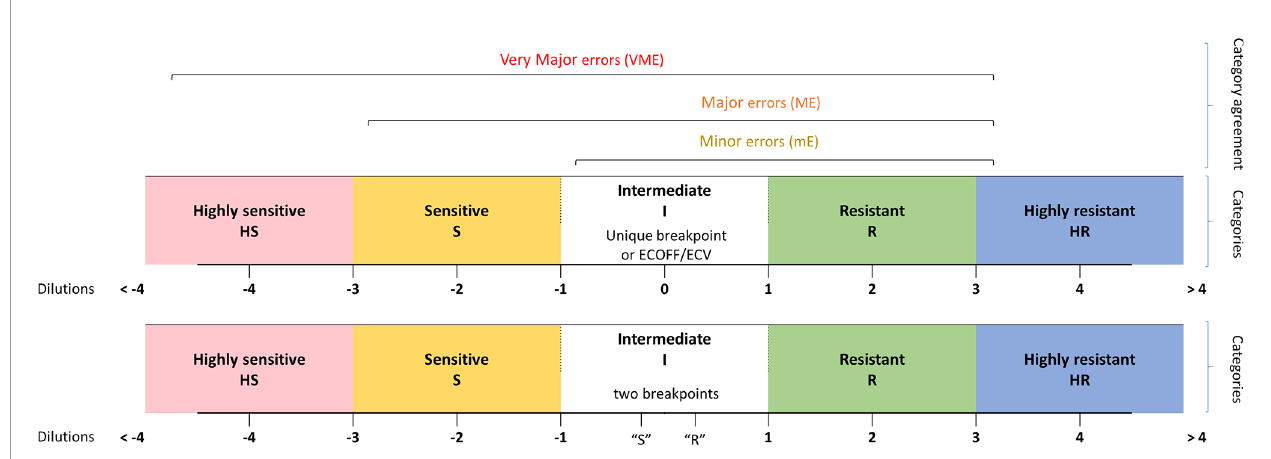
FIGURE 1 | De fi nition of the MIC categories and agreement levels. Five MIC categories were de fi ned from highly sensitive (HS) to highly resistant (HR), based on dilution differences from a reference MIC value [breakpoint (s)